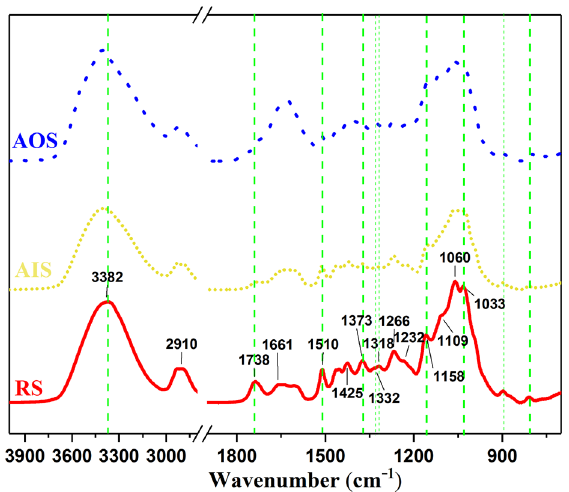
Figure 5. FT-IR spectra of RS (red), AIS (yellow), and AOS Figure 5. FT ‐ IR spectra of RS (red), AIS (yellow), and AOS (blue).